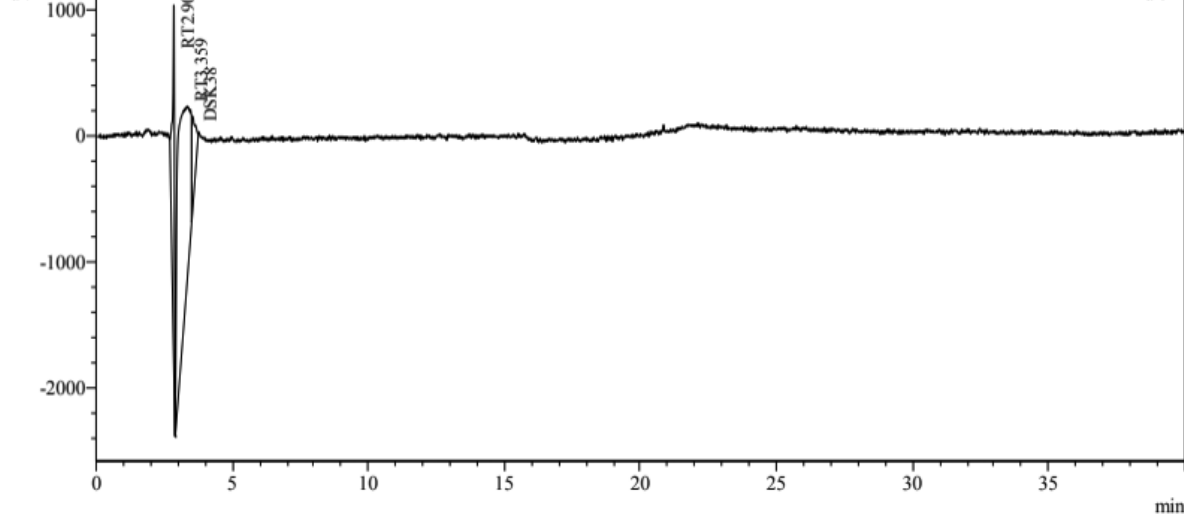
Figure 4. Chromatogram of blank solution.